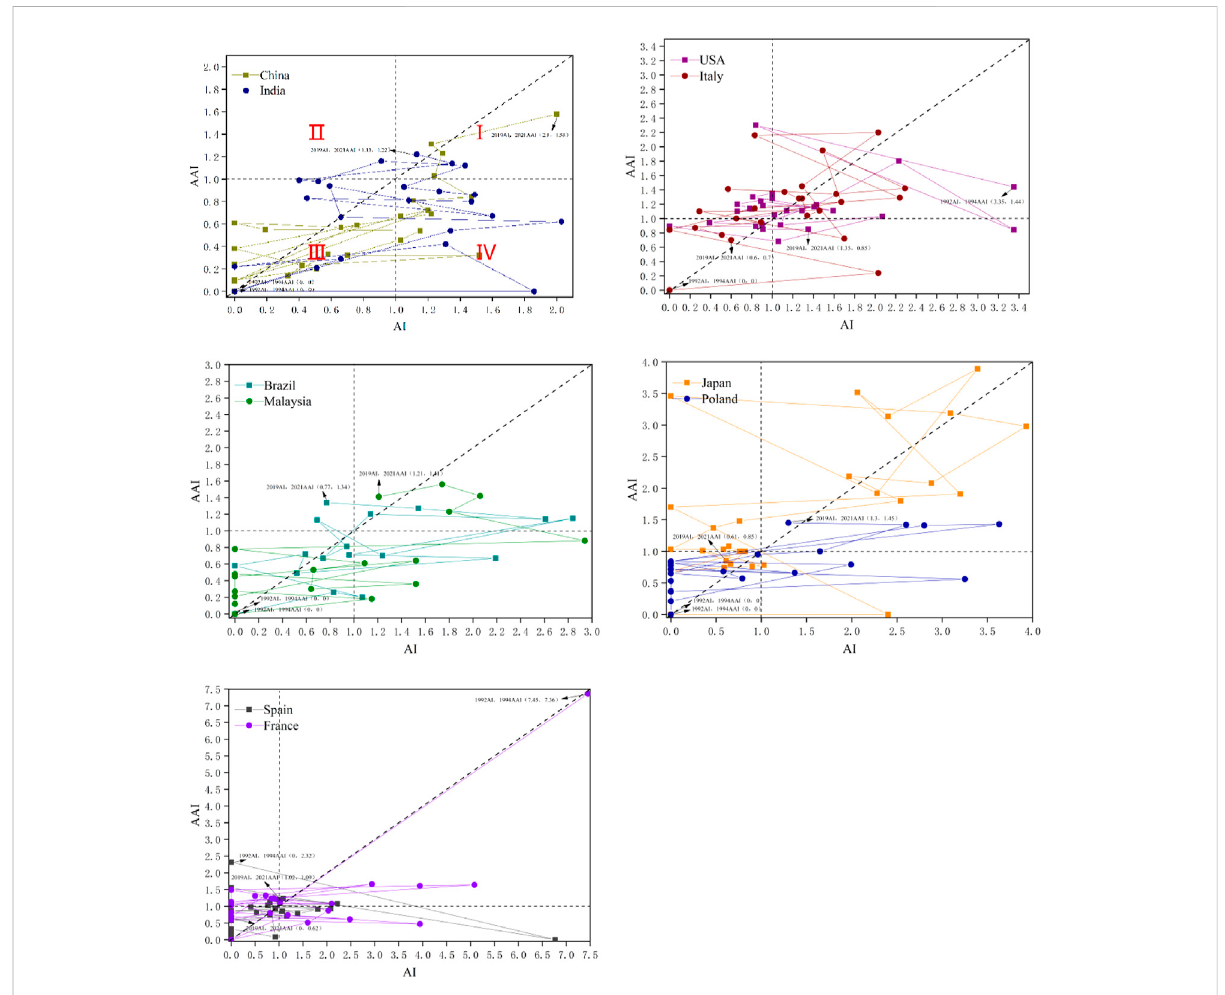
FIGURE 5 Relational chart of AI and AAI from 1992 to 2021 for 10